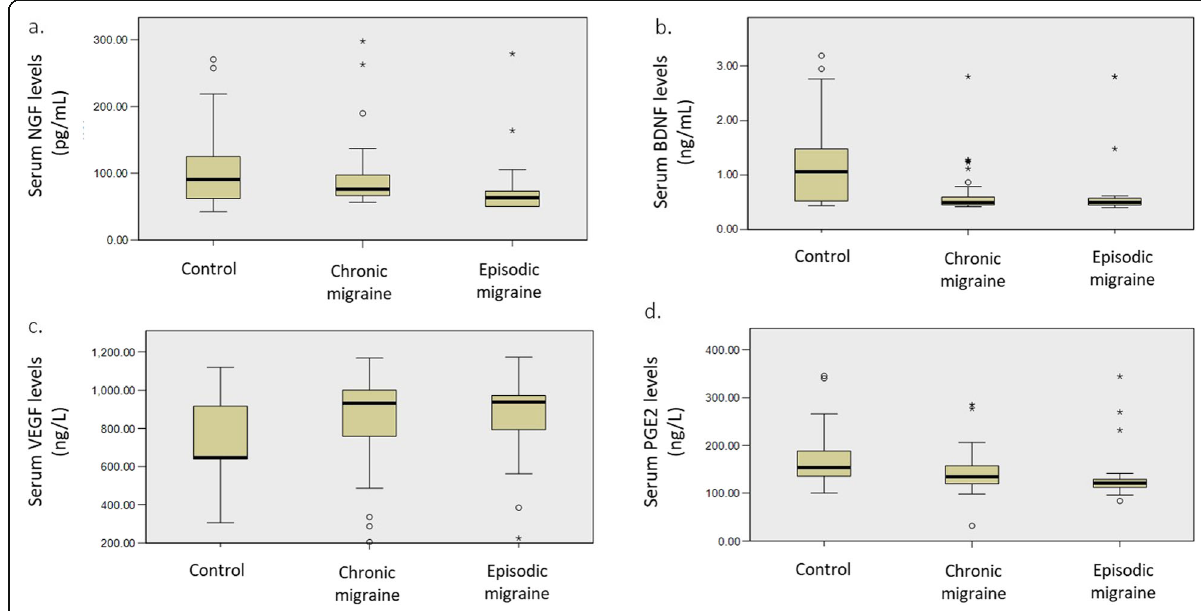
Fig. 1 Serum levels of NGF, BDNF, VEGF and PGE2 in EM and CM patients, and controls. A NGF ( B ) BDNF ( C ) VEGF ( D ) PGE2; NGF: nerve growth factor; BDNF: brain-derived neurotrophic factor (BDNF); VEGF: vascular endothelial growth factor; PGE2: prostaglandin E2; EM: episodic migraine; CM: chronic